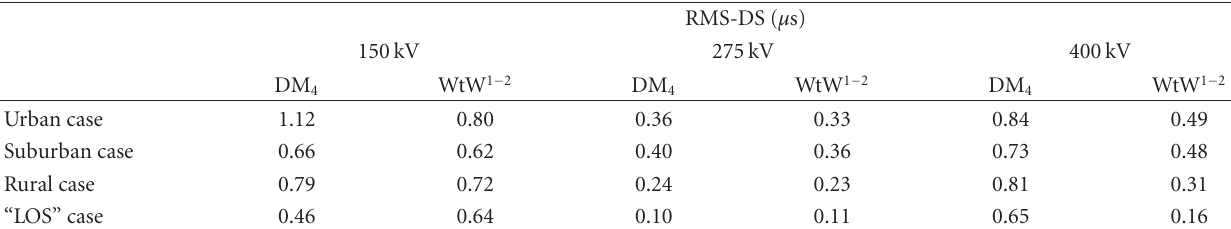
Table 2: RMS-DS for various overhead HV/BPL configurations and topologies.